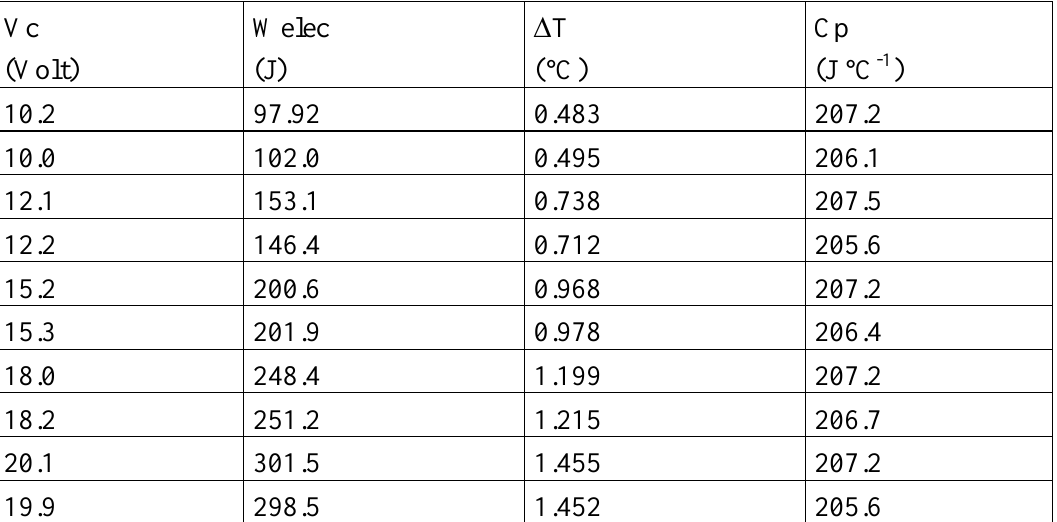
Table 1. Determination of the Heat Capacity of the Cell-Water System at 25.0 °C.